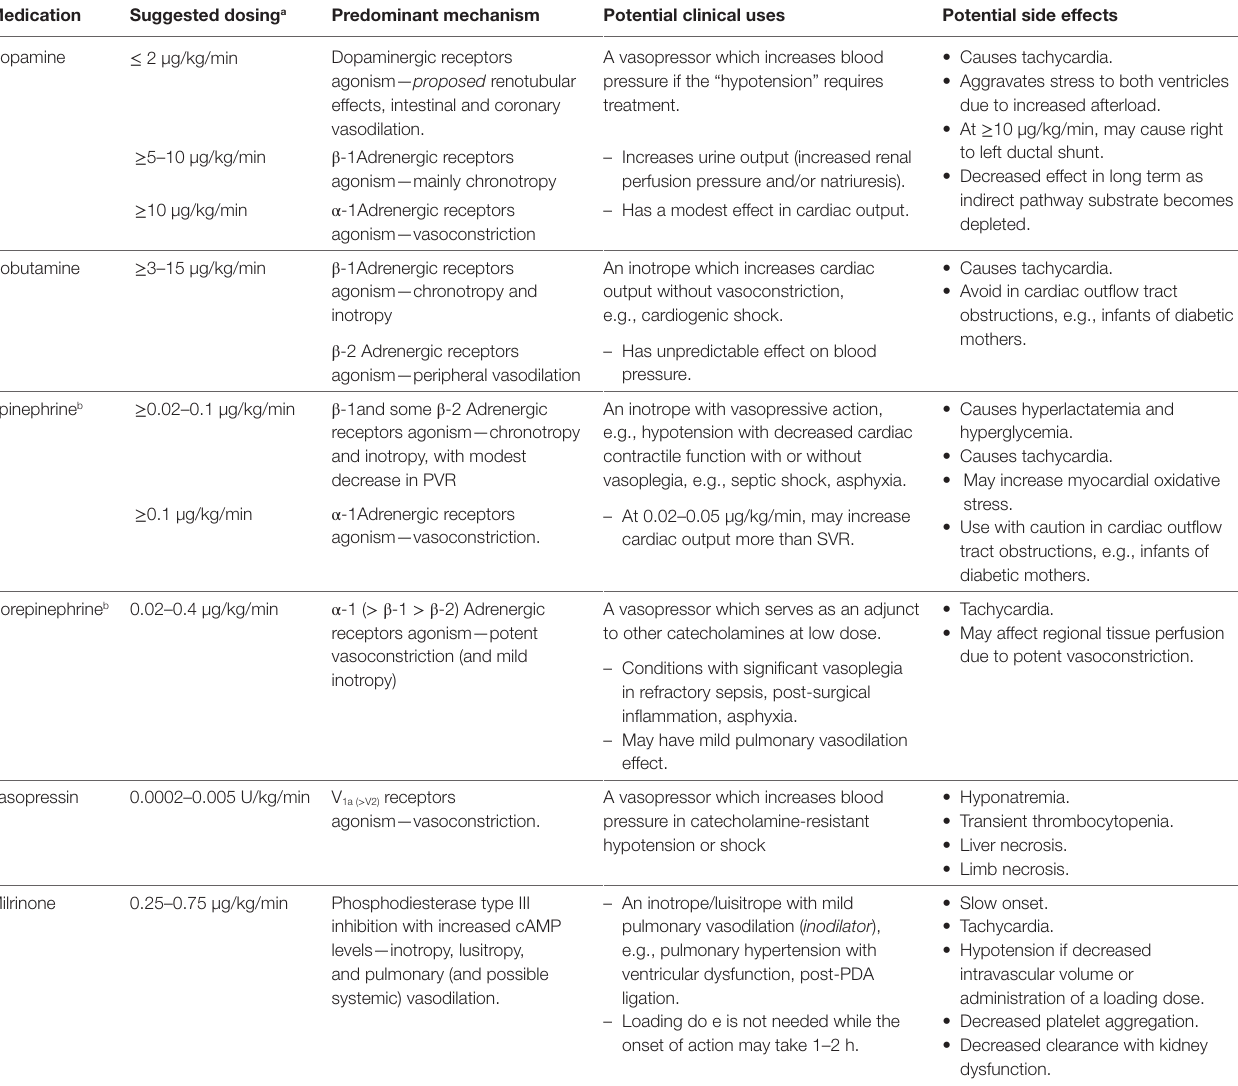
TAble 1 | Summary of antihypotensive medications in preterm